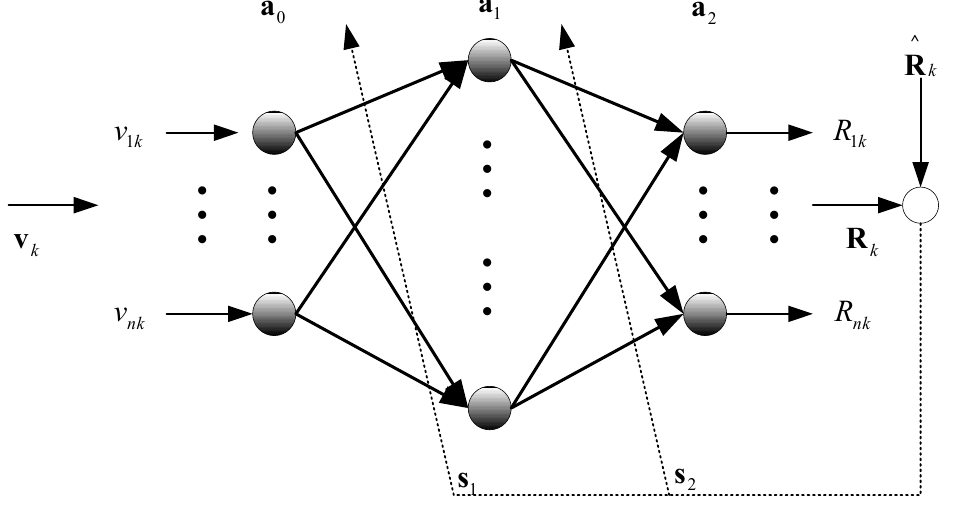
Figure 4. Neural network for evaluating measurement noise